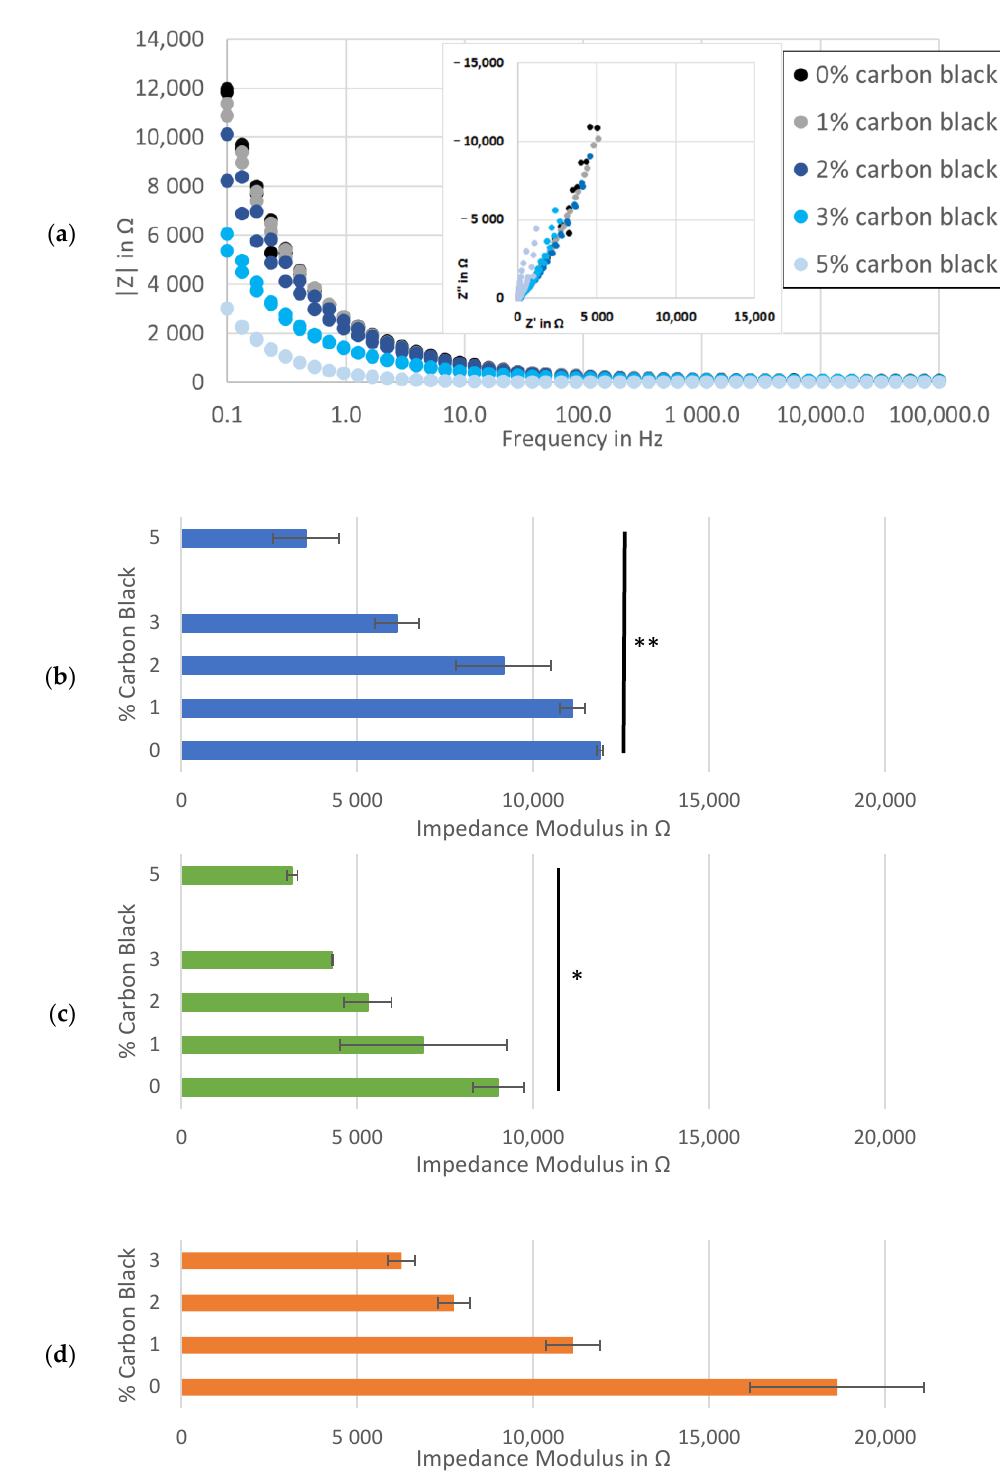
Figure 3. Impedance analysis of symmetrical cells with matching Kuranode hard carbon electrodes, showing impedance magnitude: ( a ) as a Bode plot with Nyquist on the inset; ( b ) average at 0.1 Hz in the standard electrolyte; ( c ) average at 0.1 Hz with substituted low-viscosity solvent and ( d ) average at 0.1 Hz of cells using MTI hard carbon electrodes. the error bars indicate the standard deviations, and * p < 0.05 and ** p < 0.005.